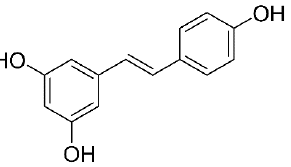
Figure 1. Chemical structure of (E)-resveratrol.